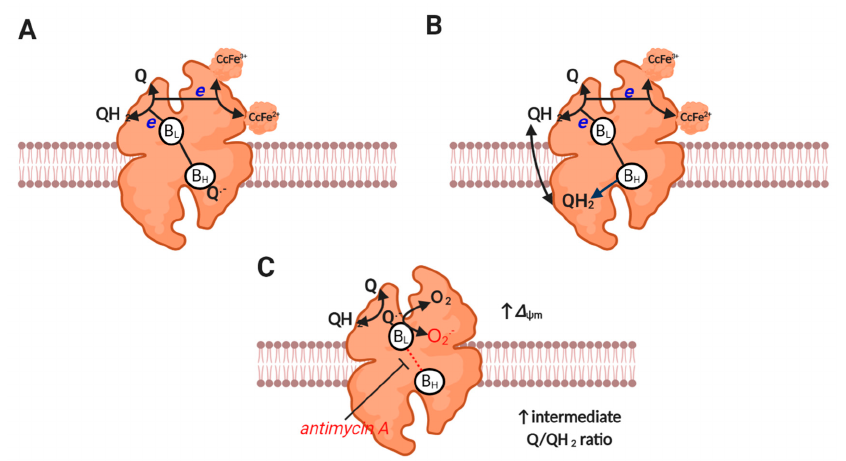
Figure 3. Complex III catalysis and superoxide production. ( A ) Depicts the first step of the proton motive Q cycle. UQH 2 -derived electrons bifurcate to B L and Rieske protein to reduce a bound Q to Q − at B H and cytochrome c at cytochrome c1 reductase (both subunits are omitted for clarity). ( B ) Depicts the second step of the proton motive Q cycle wherein repeating step A results in the reduction of the bound Q to QH 2 at B H . Release of QH 2 -derived protons on the P side of the membrane generates ∆ p . Electrons tunneling between H L and B H do so against the prevailing ∆ p (it is electrogenic). ( C ) Depicts superoxide production. A moderate to high ∆Ψ m slows electron transfer between B L and B H . Reduced B L reduces Q to Q − , which then reacts with O 2 to produce superoxide (semi-reverse mechanism). Equally, a semi-forward mechanism may operate. Superoxide production seems to be favored by an intermediate Q / QH 2 ratio (see main